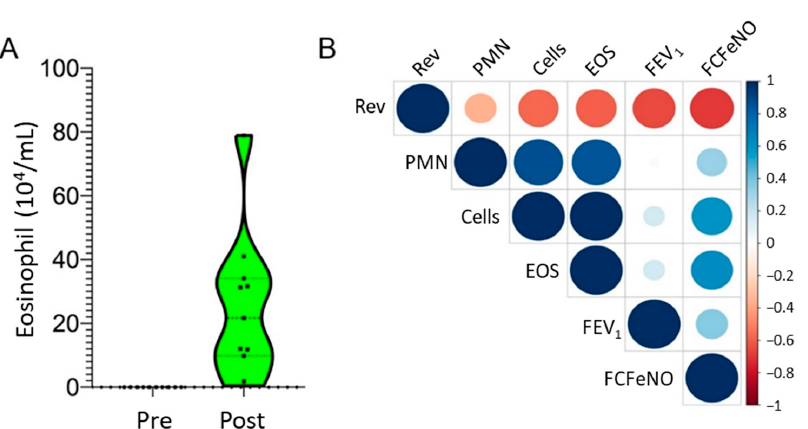
Figure 1. Phenotypic analysis of allergic asthma. ( A ) BALF eosinophil counts before and after SBP-Ag. Data are presented as a violin plot to demonstrate response variability. ( B ) Correlation between clinical demographic variables. Correlogram of pairwise comparison for study group demographics (Table 1). Note that change in FeNO is inversely correlated to albuterol reversibility and eosinophil (EOS) numbers are correlated with total cells and neutrophils (PMNs). Abbreviations: FCFeNO, fold change of FeNO; Rev, albuterol